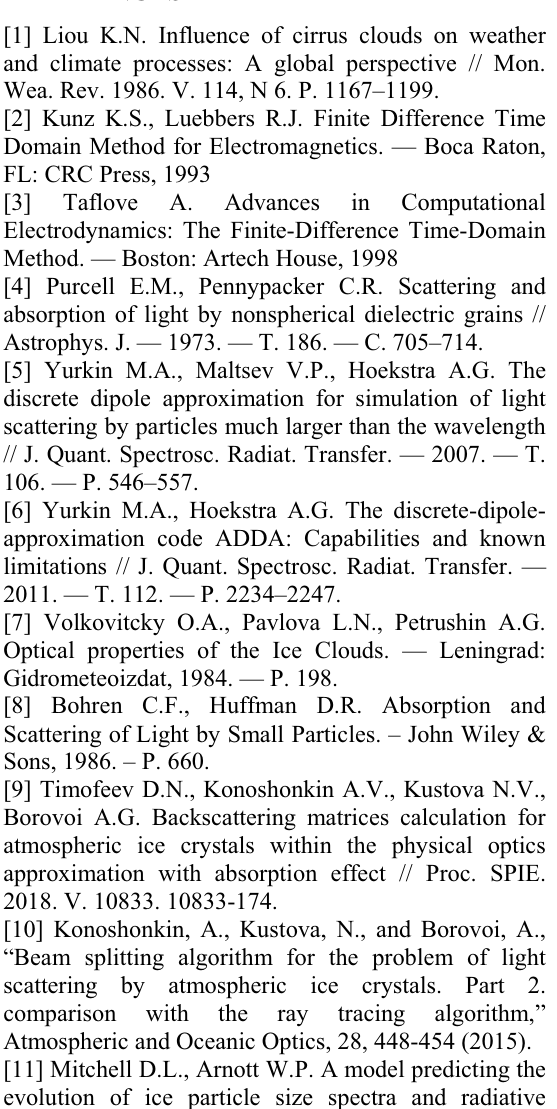
Figure 3(b) Dependence of D